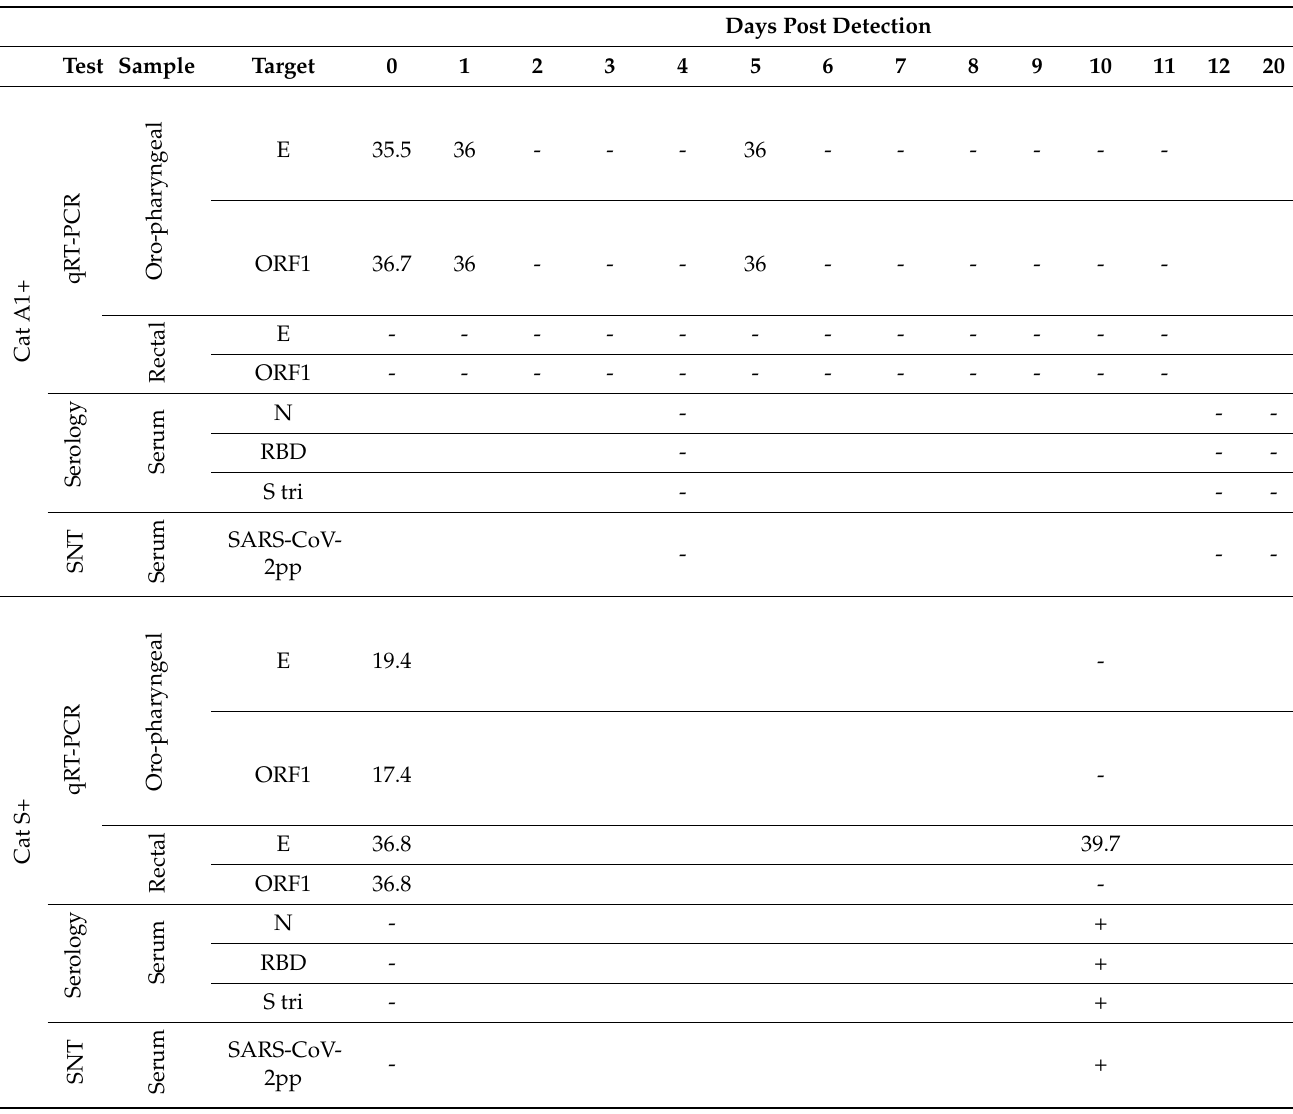
Table 1. SARS-CoV-2 qRT-PCR detection, serology, and seroneutralization on A1+ and S+ cats during the observation period. A complete sequencing of the genome was obtained from the Cat S+ samples (oropharyngeal and rectal) at day